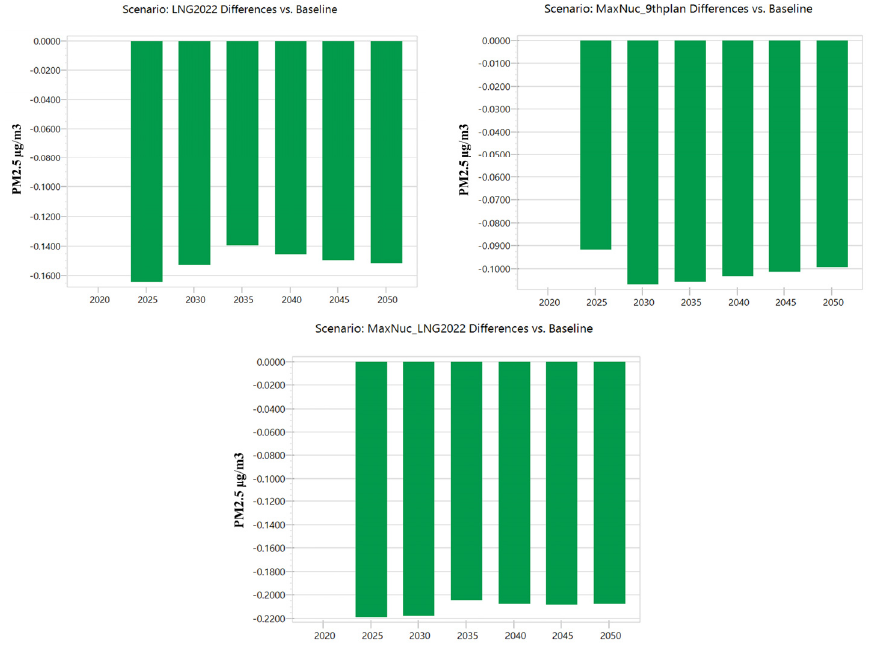
Figure 7. Reduction in population-weighted PM2.5 exposure in each alternative scenario. The health and climate benefits of all three scenarios follow the same order in terms of positive impacts, as shown in Table 2. The “MaxNuc_LNG2022” scenario yields the largest benefits in terms of both avoided premature mortality, as shown in Figure 8, and also in terms of GHG emissions mitigation. Given the fact that nuclear power currently has the lowest cost per GWh produced in South Korea’s energy system, the “MaxNuc_9thplan” scenario, in which 2022 nuclear capacity is maintained and its use maximized, would